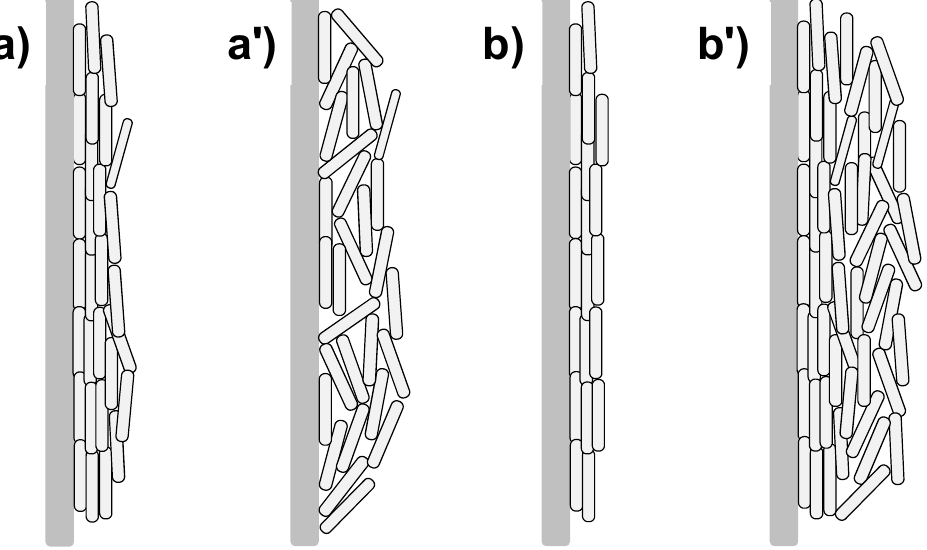
Figure 9. Deposition mechanism of boron nitride particles in the same time, under low voltage. ( a ) and high voltage ( a ′ ), and under the same low voltage for a short time ( b ) and a long time ( b ′ ).